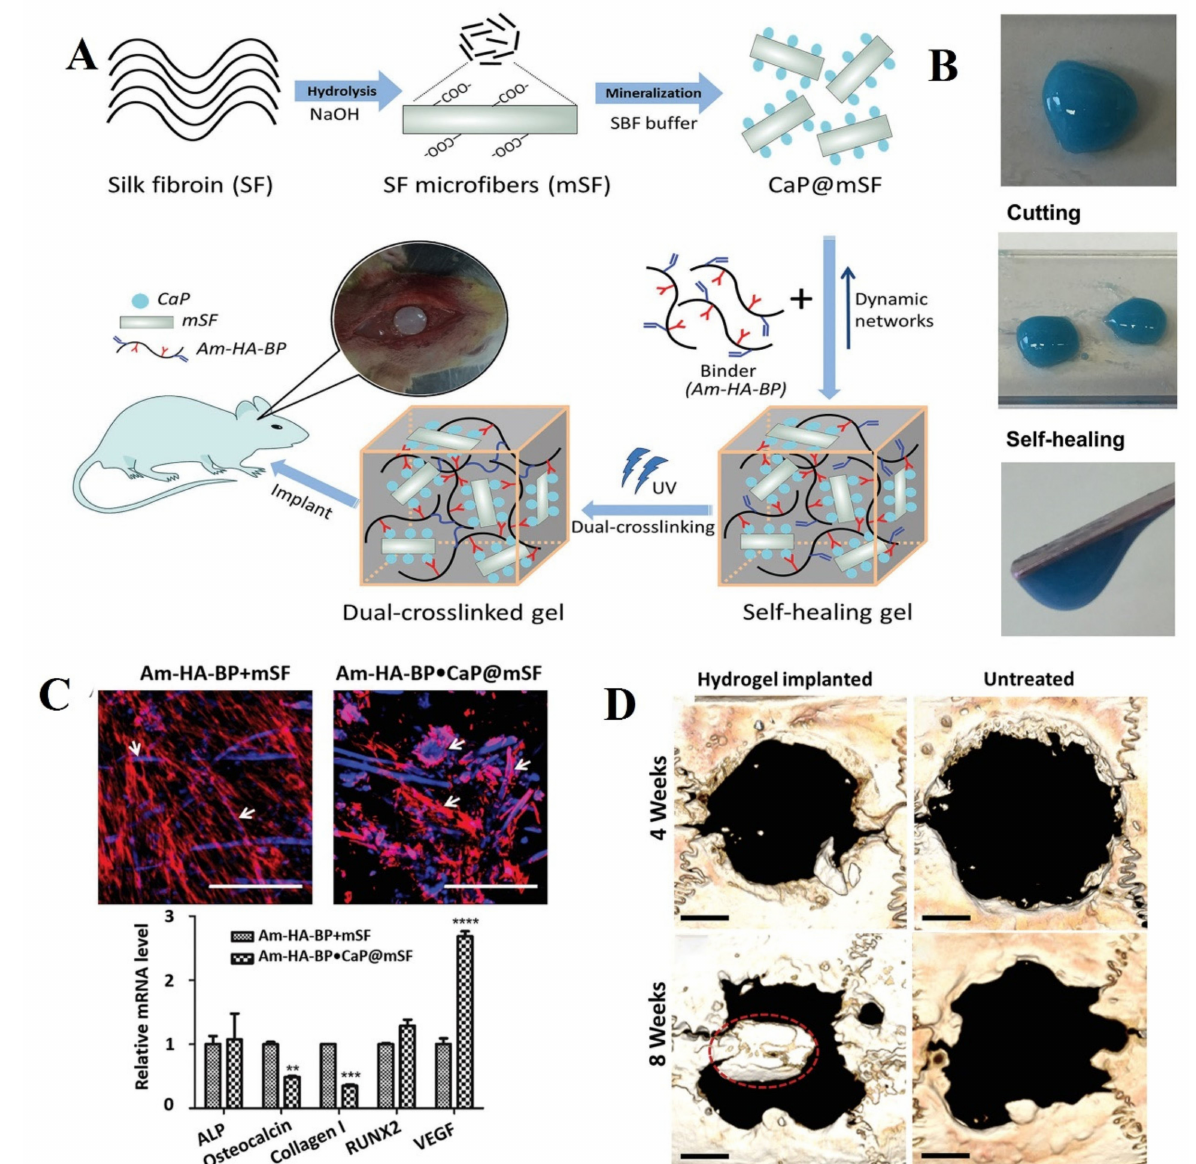
Figure 6. Schematic of silk self-healing hydrogel for bone tissue. ( A ) The design of the self-healing hydrogel formation. ( B ) Illustration of the ability of self-healing hydrogel after cutting into pieces. ( C ) The hMSCs expanding within the hydrogels were evaluated by staining cell cytoskeleton with phalloidin (red) and nucleus with Hoechst (blue). The relative osteogenesis gene expression was assessed from hMSCs on the hydrogel. ( D ) The improvement of bone formation in a rat cranial defect site after treatment with self-healable hydrogel. Reused permission with from [78] Copyright © 2021 Advanced Functional